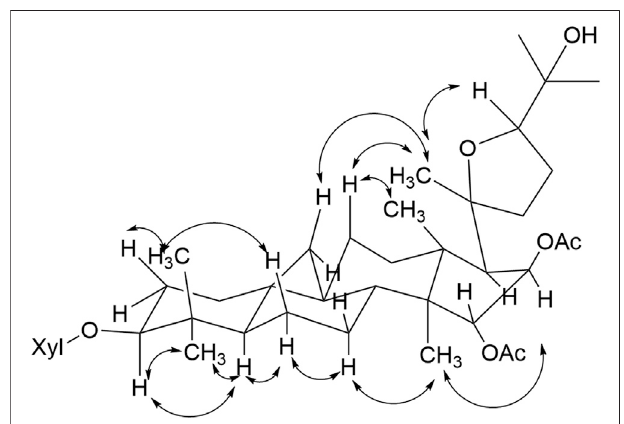
FIGURE 3 | Key NOESY correlations of compound